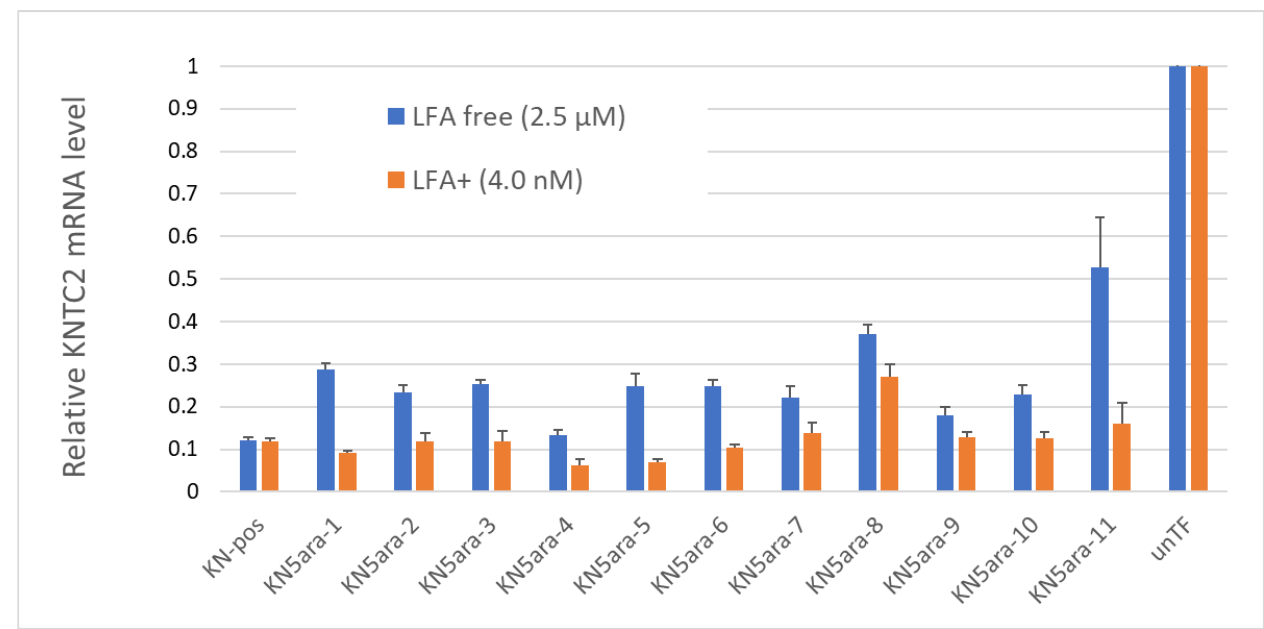
Figure 4. Relative KNTC2 mRNA levels of each KN5ara gapmer. A549tGFP cells were treated with KN5ara gapmers at different final concentrations: 2.5 µM for lipofection-free group and 4.0 nM for 0.3% Lipofectamine ® 2000 (LFA) treated group. LFA-free groups were incubated with the gapmers for 48 h, and further incubated for 24 h after exchanging medium. LFA+ groups were incubated with the gapmers for 24 h, and further incubated for 24 h after exchanging medium. Treatment without gapmers was used as a control (unTF). The total mRNA inside cells were extracted, followed by the reverse transcription of the targeted KNTC2 mRNA. Quantitative real-time polymerase chain reaction (qRT-PCR) was performed in duplicate, and the relative KNTC2 mRNA levels were calculated via the ddCT